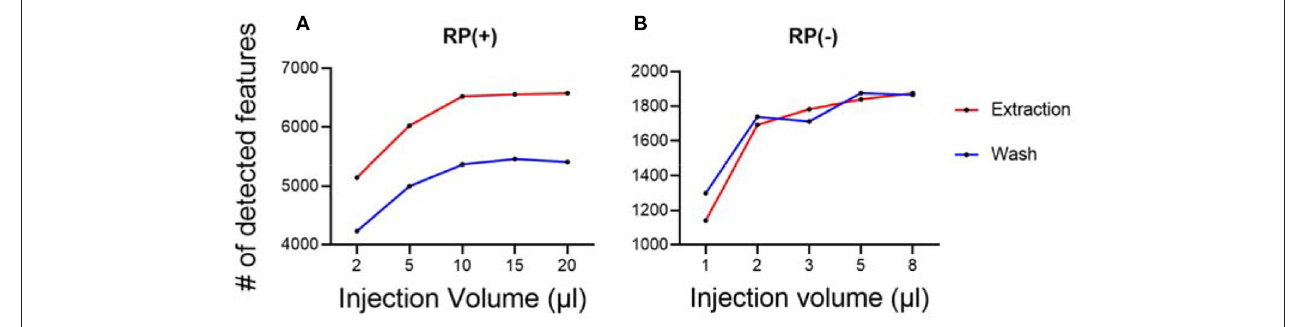
FIGURE 3 | Optimization of sample injection amount for LC-MS analysis. (A) RP( + ); (B) RP(–). Each condition has three